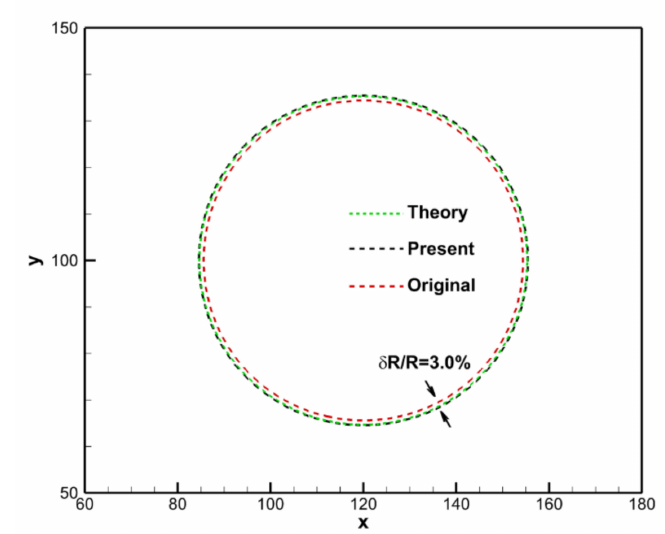
Figure 12. Comparison of the final interfaces for the merging